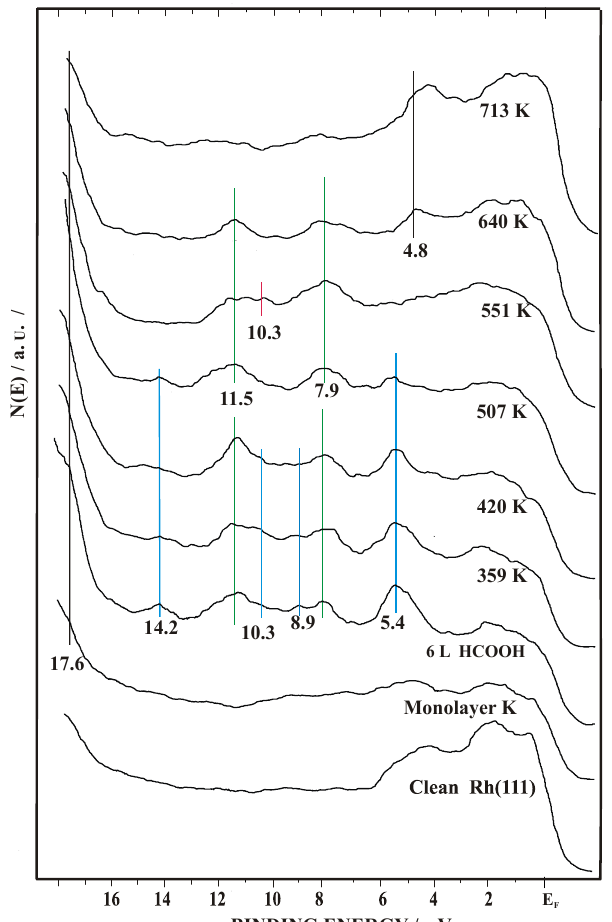
Figure 7. UP spectra after adsorption of FA on potassium covered Rh(111) at monolayer K coverage, Θ K = 0.3 at 300 K and subsequent heat treatment. FA exposure was 12 L.